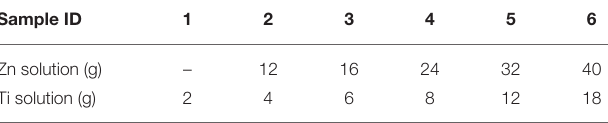
TABLE 2 | Sample series, amount of solution sprayed in grams denoted according to this numbering Zn2, Zn3, … and Ti1, Ti2…